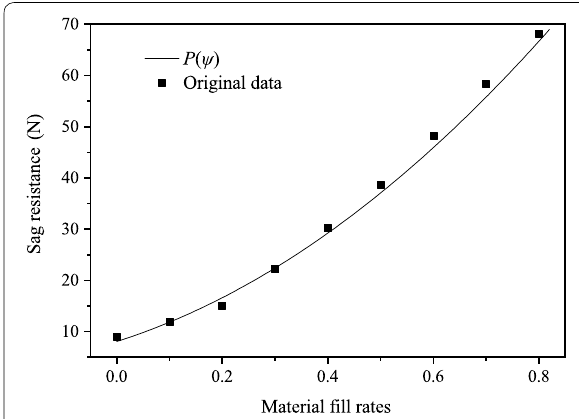
Figure 9 Relationship between sag resistance and normal force with different rollers spacing